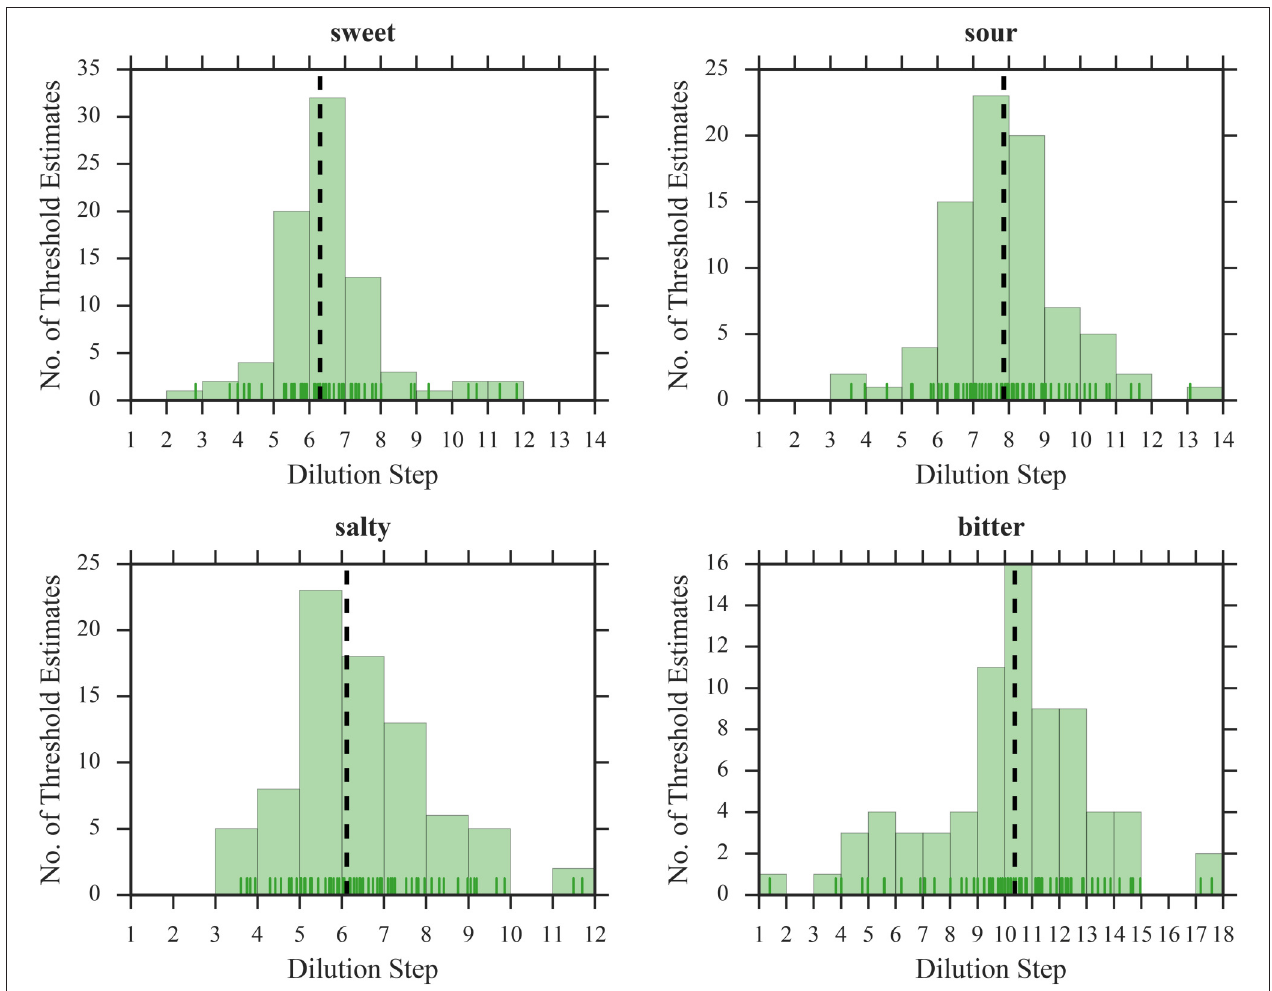
FIGURE 2 | Distribution of threshold estimates for QUEST. Blue vertical lines depict individual participants; black dashed lines represent the